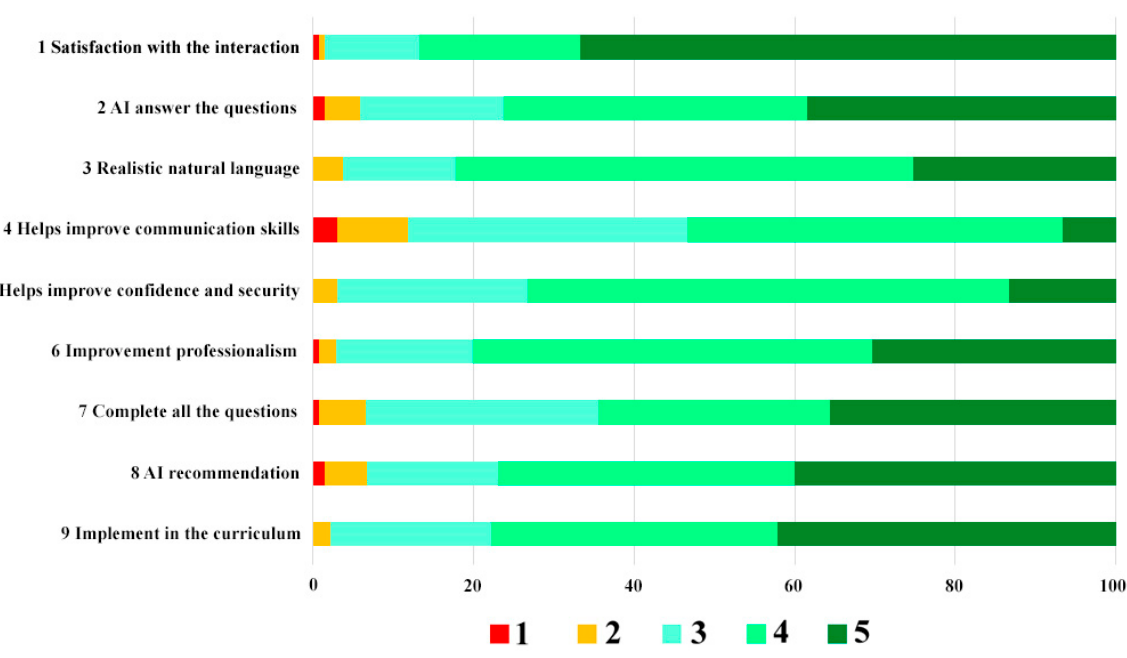
Figure 7. Distribution of responses per questionnaire item by fifth year dental students. 1-Strongly Disagree, 2-Disagree, 3-Neutral, 4-Agree, 5-Strongly Agree.